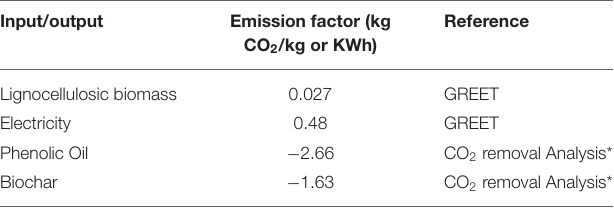
TABLE 5 | Greenhouse gas emission factors of key material and energy flows of the autothermal pyrolysis to sugar, phenolic oil, and biochar biorefinery.